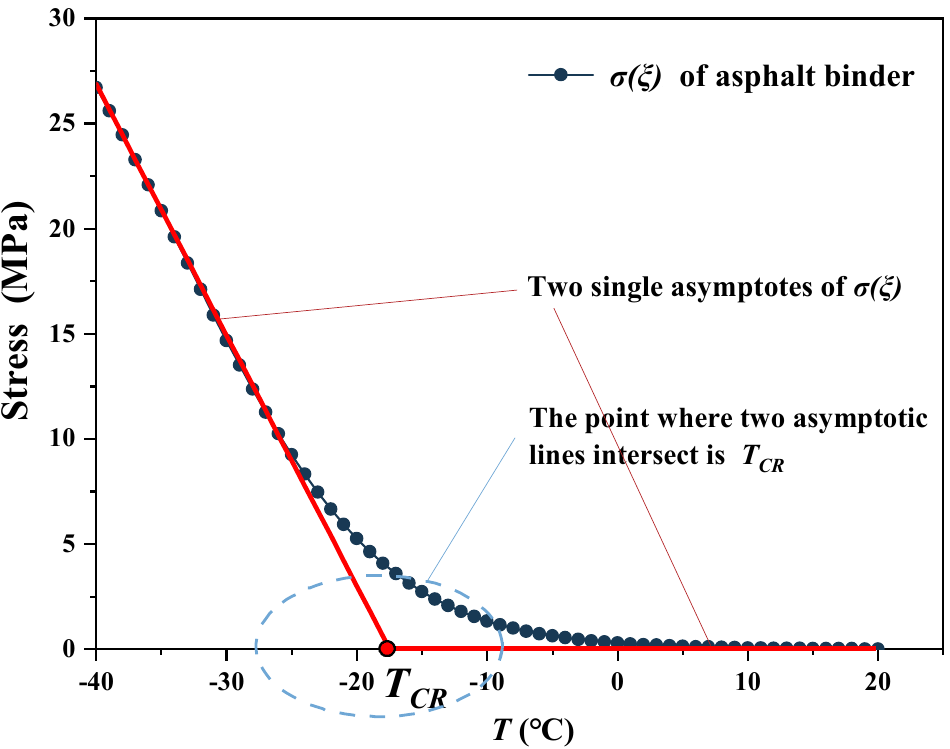
Figure 2. Temperature stress and TCR calculation according to the SAP theory [54].